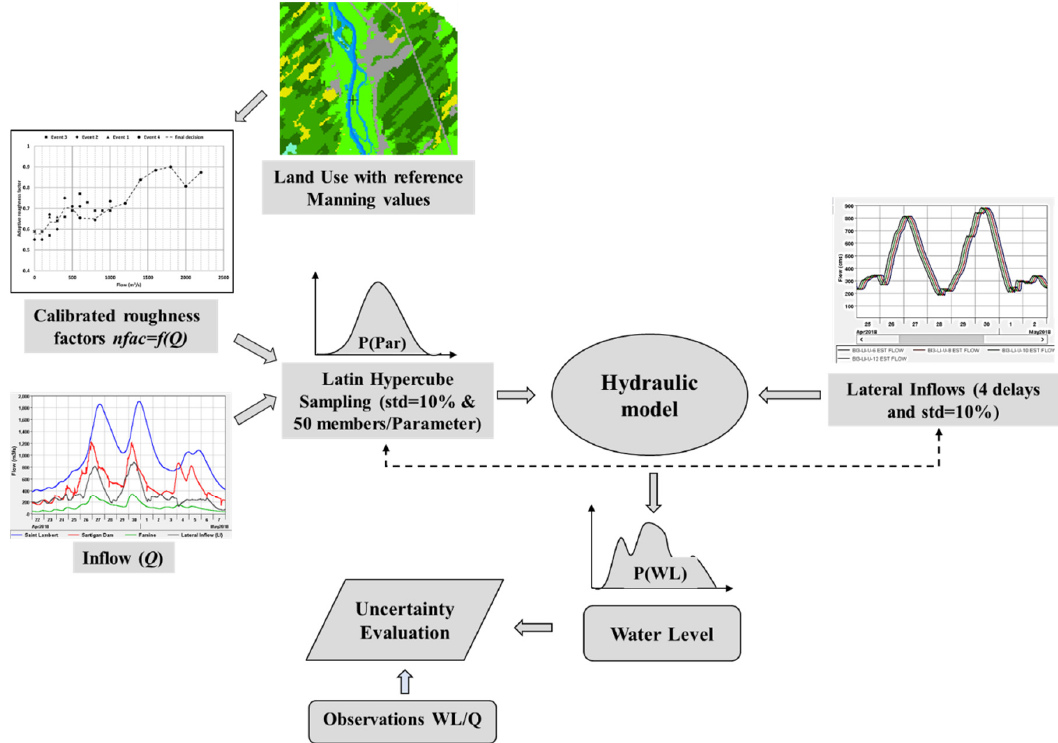
Figure 7. Uncertainty analysis framework.